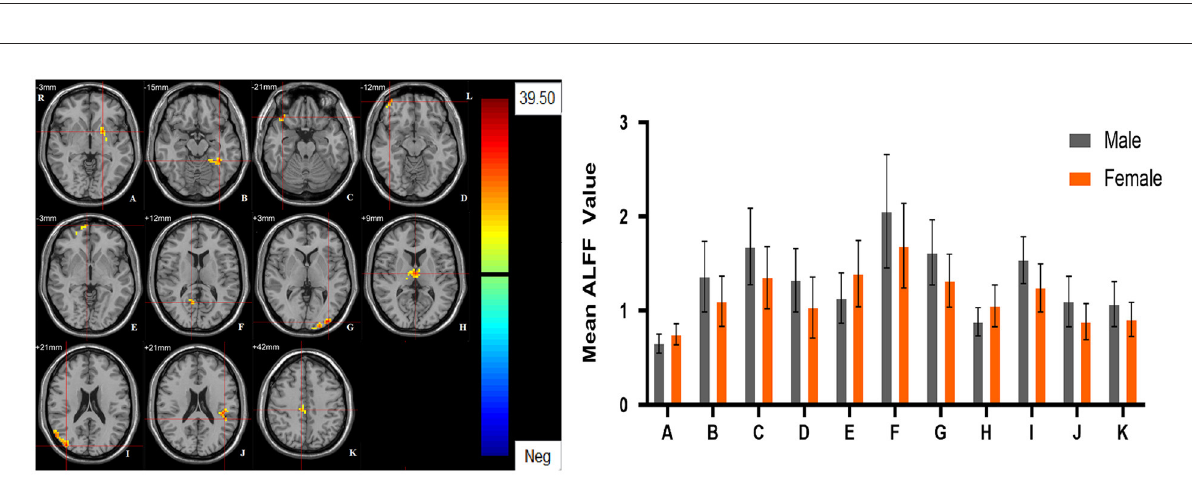
FIGURE2 The main effect of sex group. Regions with a main effect of sex group included (A) The left putamen; (B) The left lingual gyrus, the left calcarine and the left inferior temporal gyrus; (C) The right orbital inferior frontal gyrus; (D) The right orbital middle frontal gyrus; (E) The right orbital medial frontal gyrus; (F) The right calcarine; (G) The left middle occipital lobe; (H) The bilateral thalamus; (I) The right middle occipital lobe; (J) The left superior temporal gyrus; (K) The right median cingulate gyrus (cluster-level threshold of p < 0.05 after GRF correction). The color bar represents the range of F values. R = right, L = left. The graph shows the ALFF values (mean ± standard deviation) extracted from regions with a main effect of sex group. The Y-axis represents ALFF values. The X-axis represents regions with a main effect of sex group.